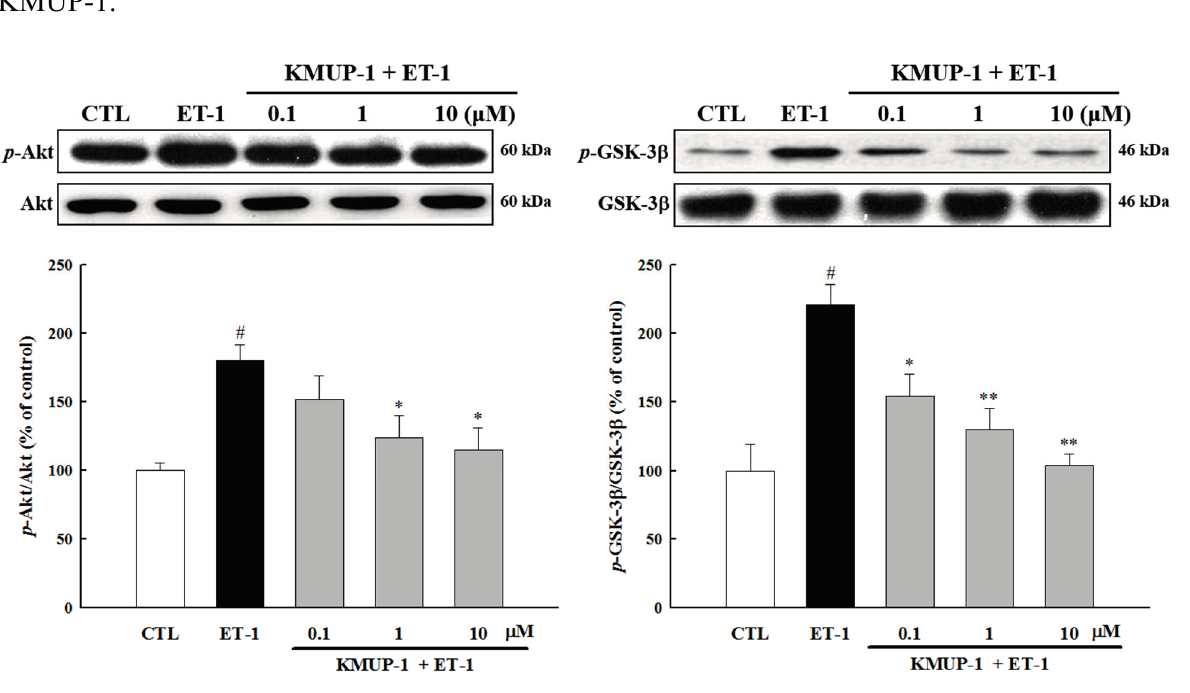
Figure 4. Effects of KMUP-1 on the Akt/GSK-3 β pathway. H9c2 cells were treated